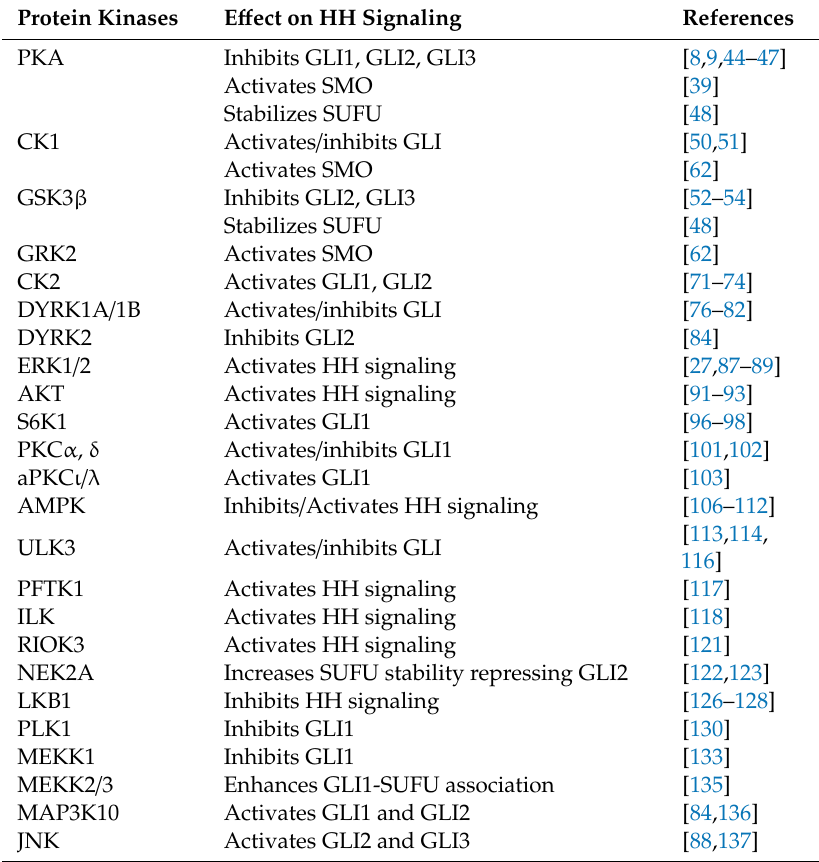
Table 1. Protein kinases involved in the regulation of HH pathway in mammalian. Protein